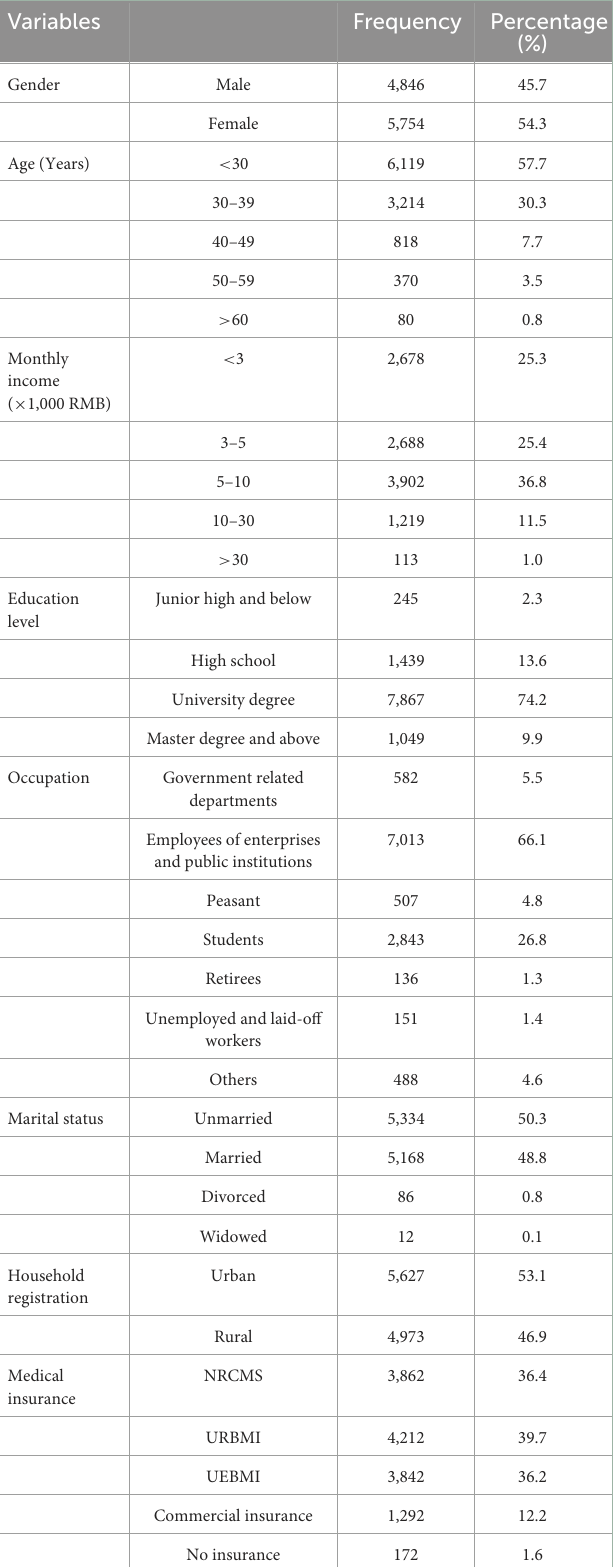
TABLE 1 Descriptive characteristics of